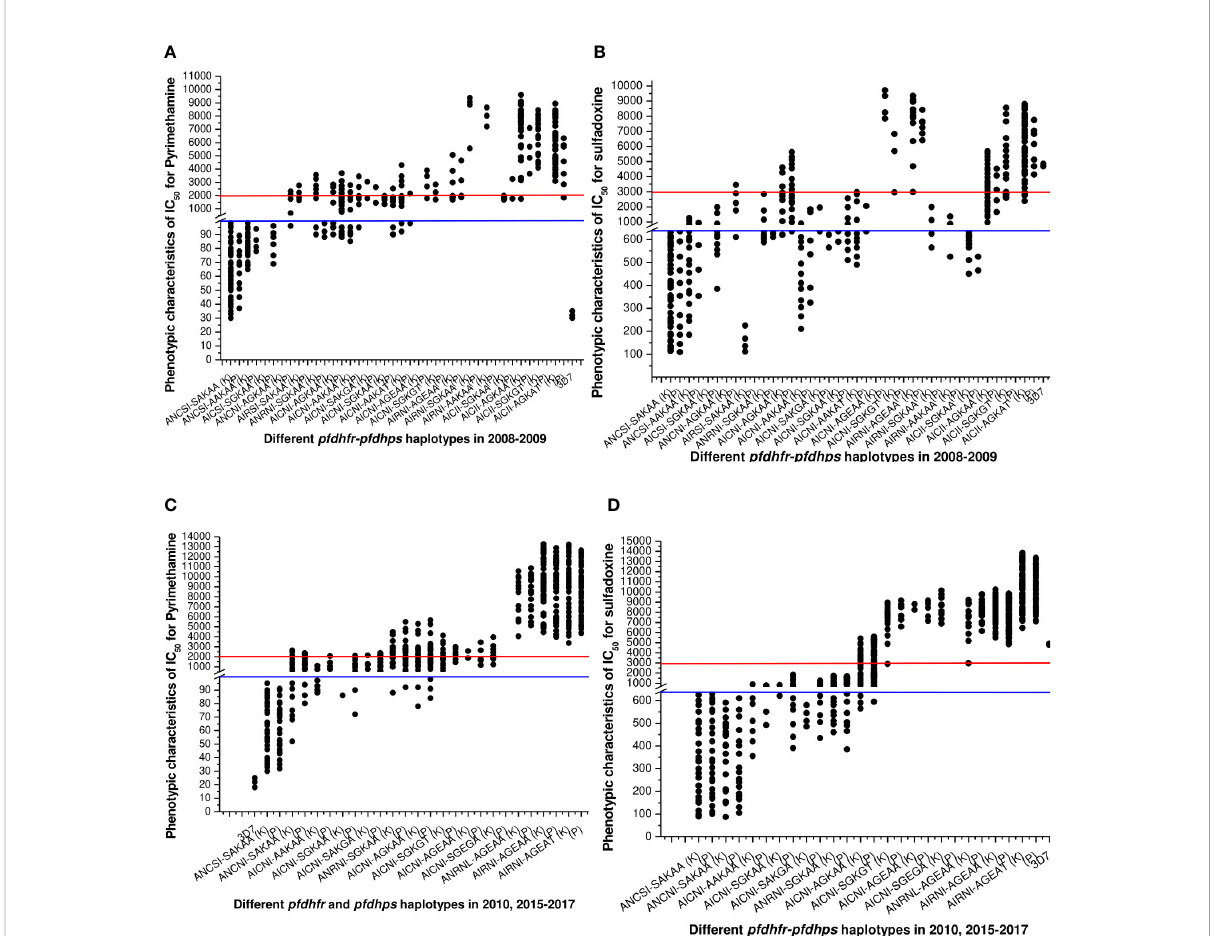
FIGURE 4 (A) Association of in vitro pyrimethamine sensitivity (expressed as the IC 50 of pyrimethamine) with different pfdhfr and pfdhps haplotype combination before new national drug policy. Here, blue line (corresponding to 100 nM of PYR) was hypothetical showed the sensitive levels whereas red line (corresponding to 2000 nM of PYR) was hypothetical showed the resistance levels for in vitro pyrimethamine susceptibility. The isolates presenting pfdhfr -ANCSI, ANC N I, and AN RN I presented low to moderate IC 50 s for PYR and were not associated with in vitro PYR resistance ( P = 0.81, Kruskal – Wallis test) in both study site. (B) Association of in vitro sulfadoxine sensitivity (expressed as the IC 50 of sulfadoxine) with different pfdhfr and pfdhps haplotype combination before new national drug policy. Here, blue line (corresponding to 640 nM of SDX)